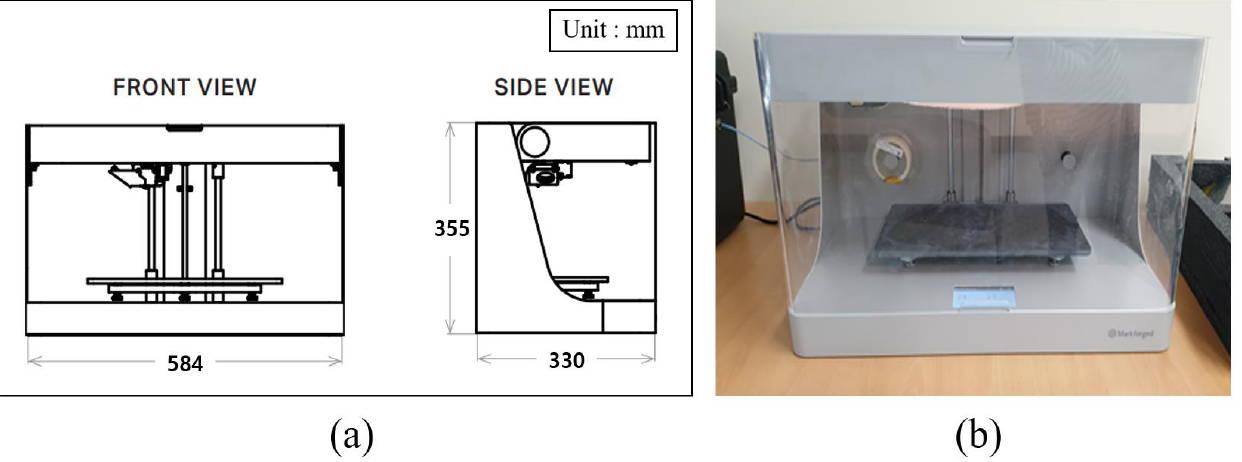
Figure 1. Schematic illustration of vibration experiment for different chuck adapters (CFRP, steel, and CFRP with steel).